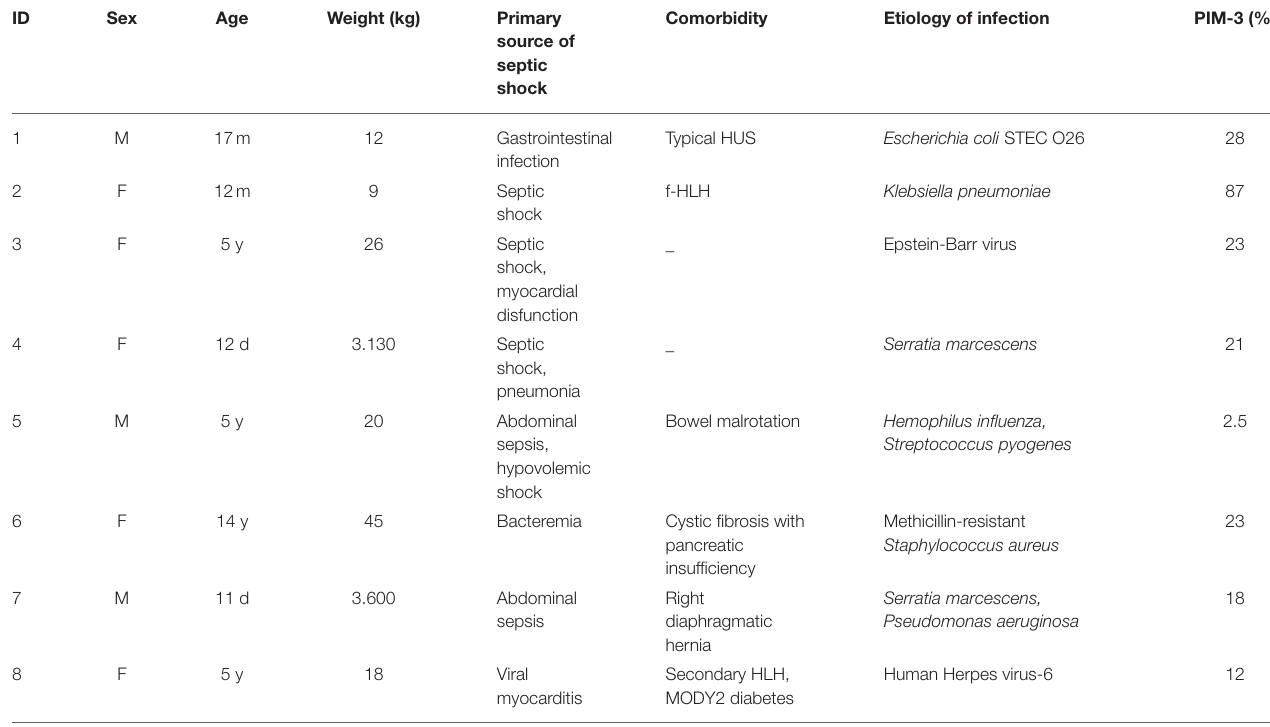
TABLE 1 | Patients’ characteristics and details on the primary source of sepsis, comorbidity, etiology of infection.